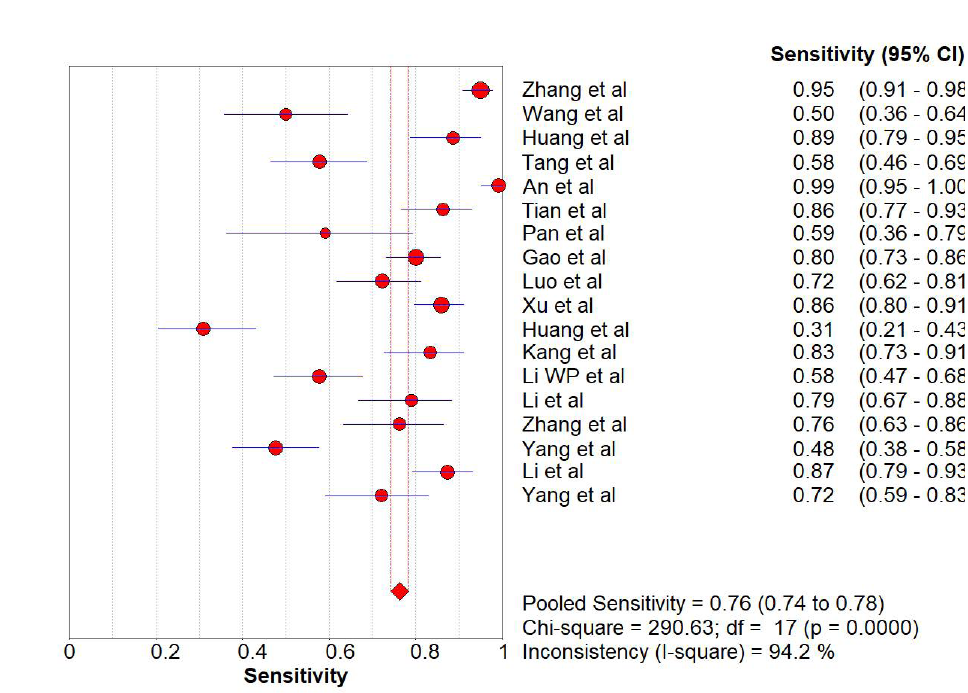
Figure 2: The forest plot of diagnostic sensitivity for serum Hcy in diagnosis of DN.